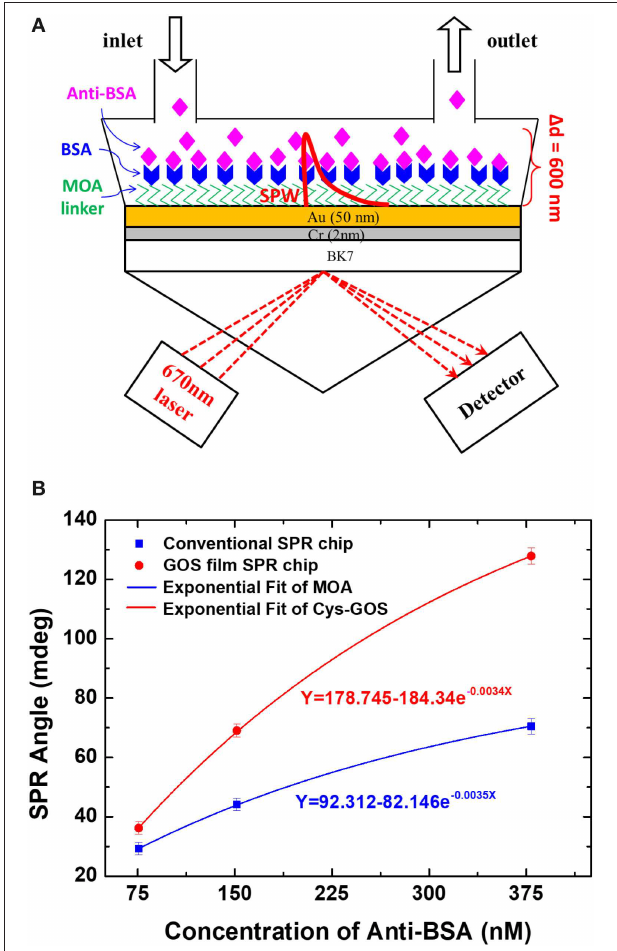
FIGURE 4 | (A) SPR experimental scheme to study the interaction of BSA and anti-BSA. (B) Equilibrium analysis of binding of anti-BSA and BSA. Figures (A,B) were reproduced from Chiu et al. (2014) with permission from the Nanoscale Research Letters. Copyright 2014, Springer Nature.